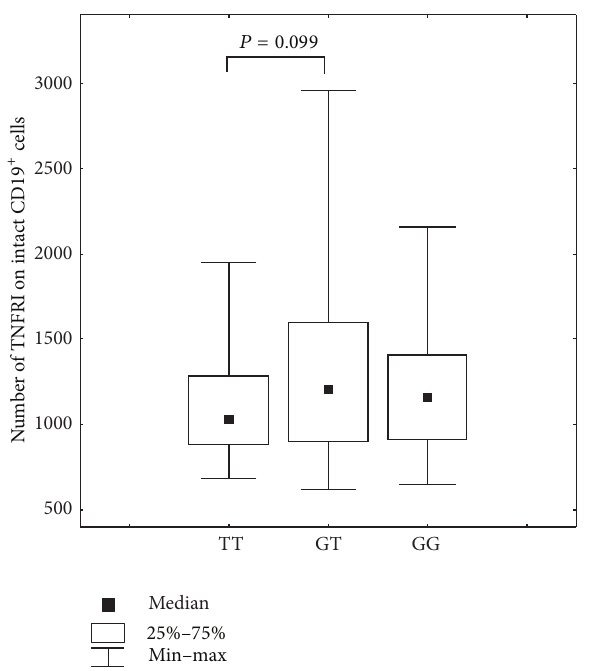
Figure 6: Number of membrane-bound TNF 𝛼 type I receptor on CD19 + B cells in individuals presenting with different SNP TNFRI − 609G/T (rs4149570) genotypes, Mann-Whitney 𝑈 test: TT versus GT, 𝑃 = 0.099